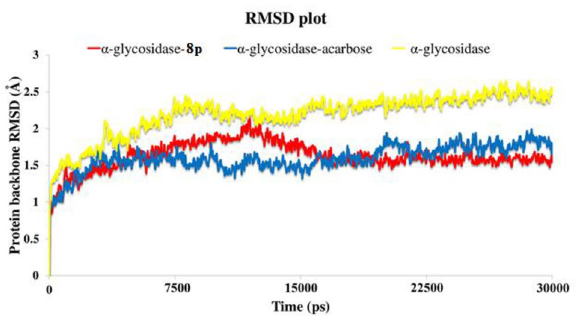
Figure 4. RMSD of the α-glycosidase backbone in complexed with acarbose (in blue), compound 8p (in red) and the unbound enzyme (in yellow) for over 30 ns MD simulation